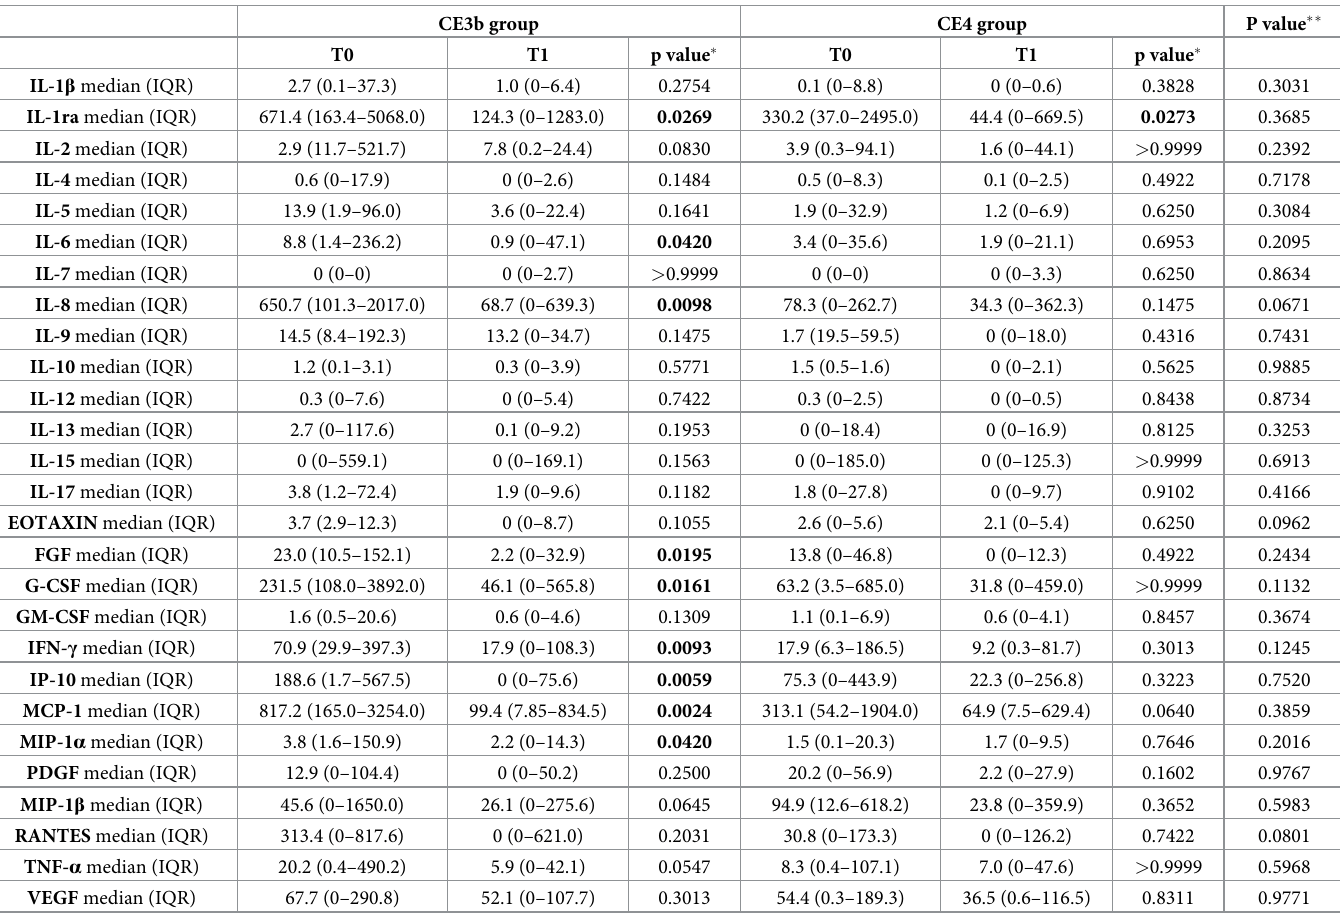
Table 2. Levels of immune/growth factors in the CE3b- and